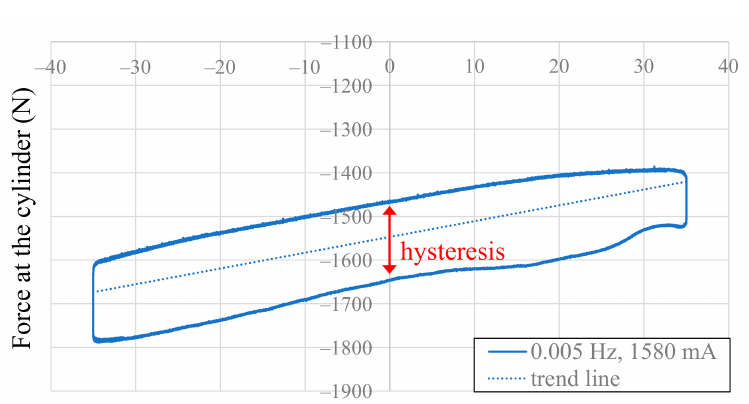
Figure 7. Force-displacement curve from test results.